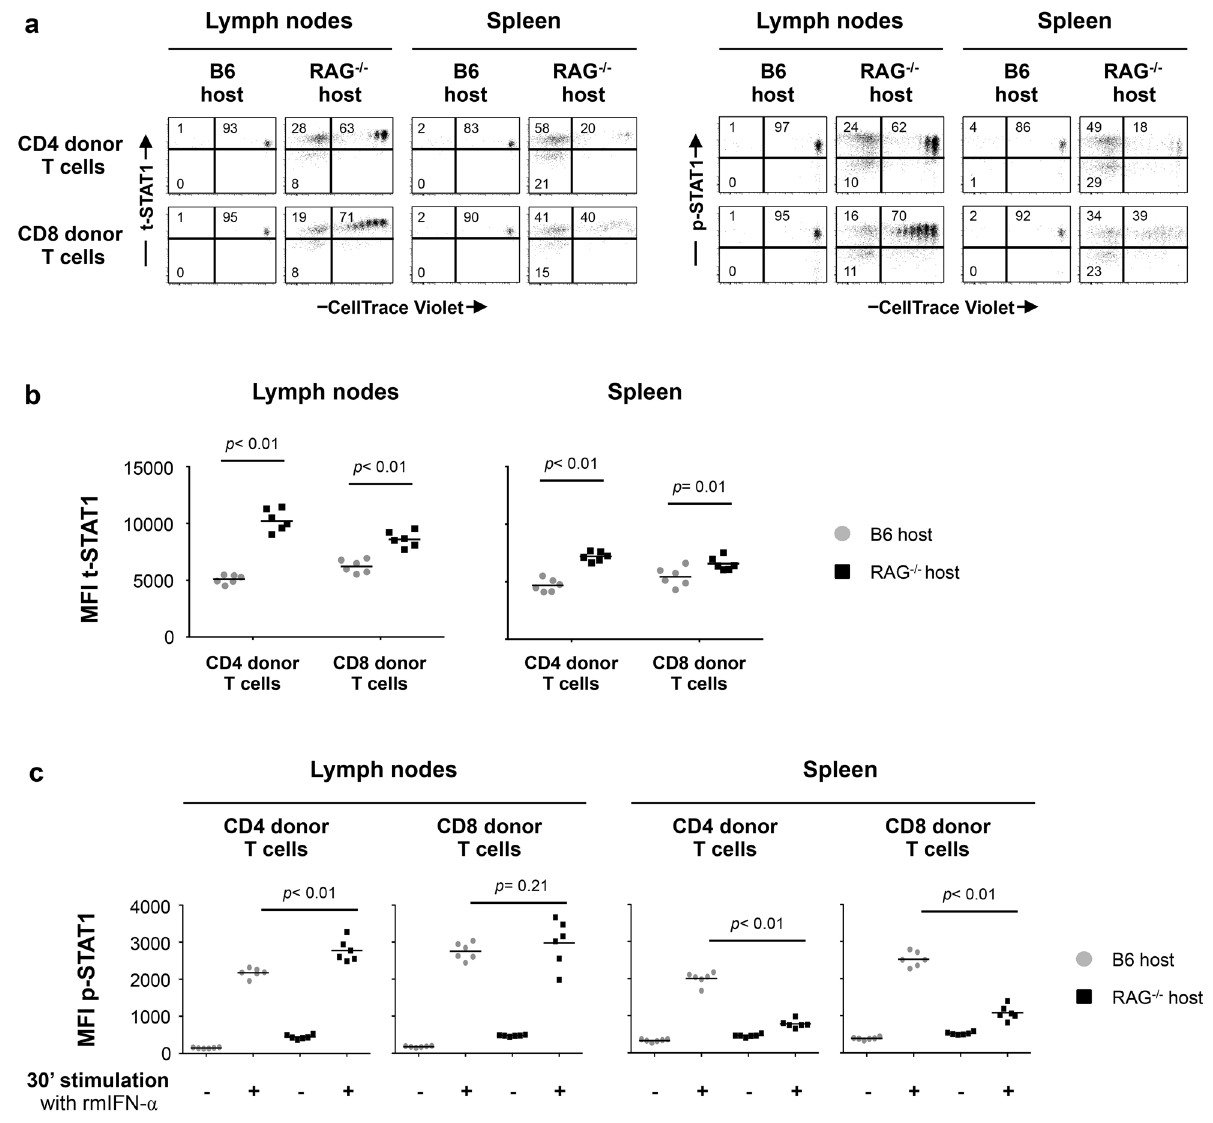
Figure 5. Invivo exposure to lymphopenic conditions enhances t-STAT1 expression and IFN- a responsiveness. Lymphoreplete B6 CD45.1 (n=6) and lymphopenic RAG 2 / 2 CD45.1 (n=6) mice were injected intravenously (i.v.) with 9 6 10 6 of CellTrace Violet-labeled lymph node (LN) cells isolated from congenic B6 CD45.2 mice. Analysis of transferred cells in LNs and spleen was performed on day 7 after transfer. The levels of t- STAT1 and p-STAT1 of donor T cells were evaluated by flow cytometry in LNs and spleen as function of CellTrace Violet Fluorescence after in vitro stimulation with rmIFN- a (500 U/ml). ( a ) The percentages of donor T cells CellTrace Violet + t-STAT1 high , CellTrace Violet 2 t-STAT1 high , CellTrace Violet 2 t-STAT1 low and CellTrace Violet + p-STAT1 high , CellTrace Violet 2 p-STAT1 high and CellTrace Violet 2 p-STAT1 low are indicated. The MFIs of t- STAT1 ( b ) and p-STAT1 ( c ) in CD4 and CD8 donor T cells seven days after adoptive transfer into replete B6 (gray symbols) and lymphopenic RAG 2 / 2 (black symbols) hosts were compared using a nonparametric Mann-Whitney test. Data are from one representative experiment out of three, including an average of 5 mice per group.